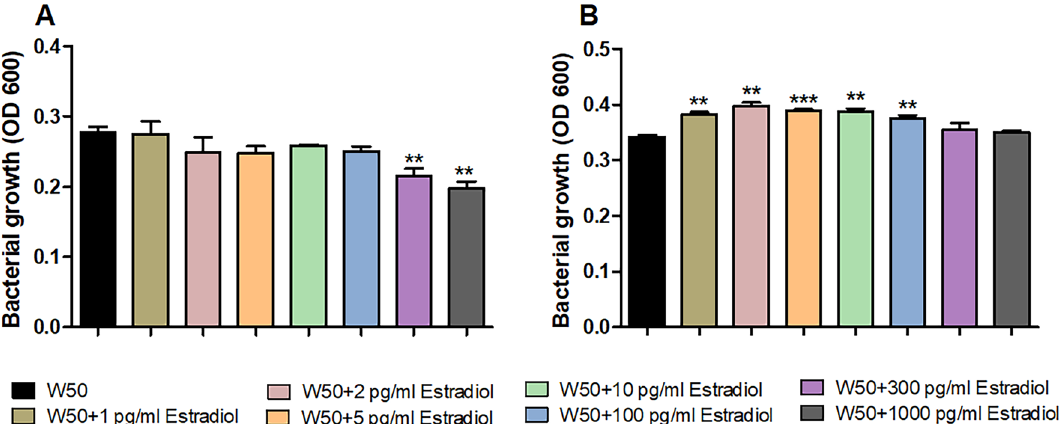
Figure 1. Estradiol alters P. gingivalis growth. P. gingivalis W50 growth with or without the presence of estradiol (1 pg/ml, 2 pg/ml, 5 pg/ml, 10 pg/ml, 100 pg/ml, 300 pg/ml and 1000 pg/ml,) after 24 h ( A ) and 72 h